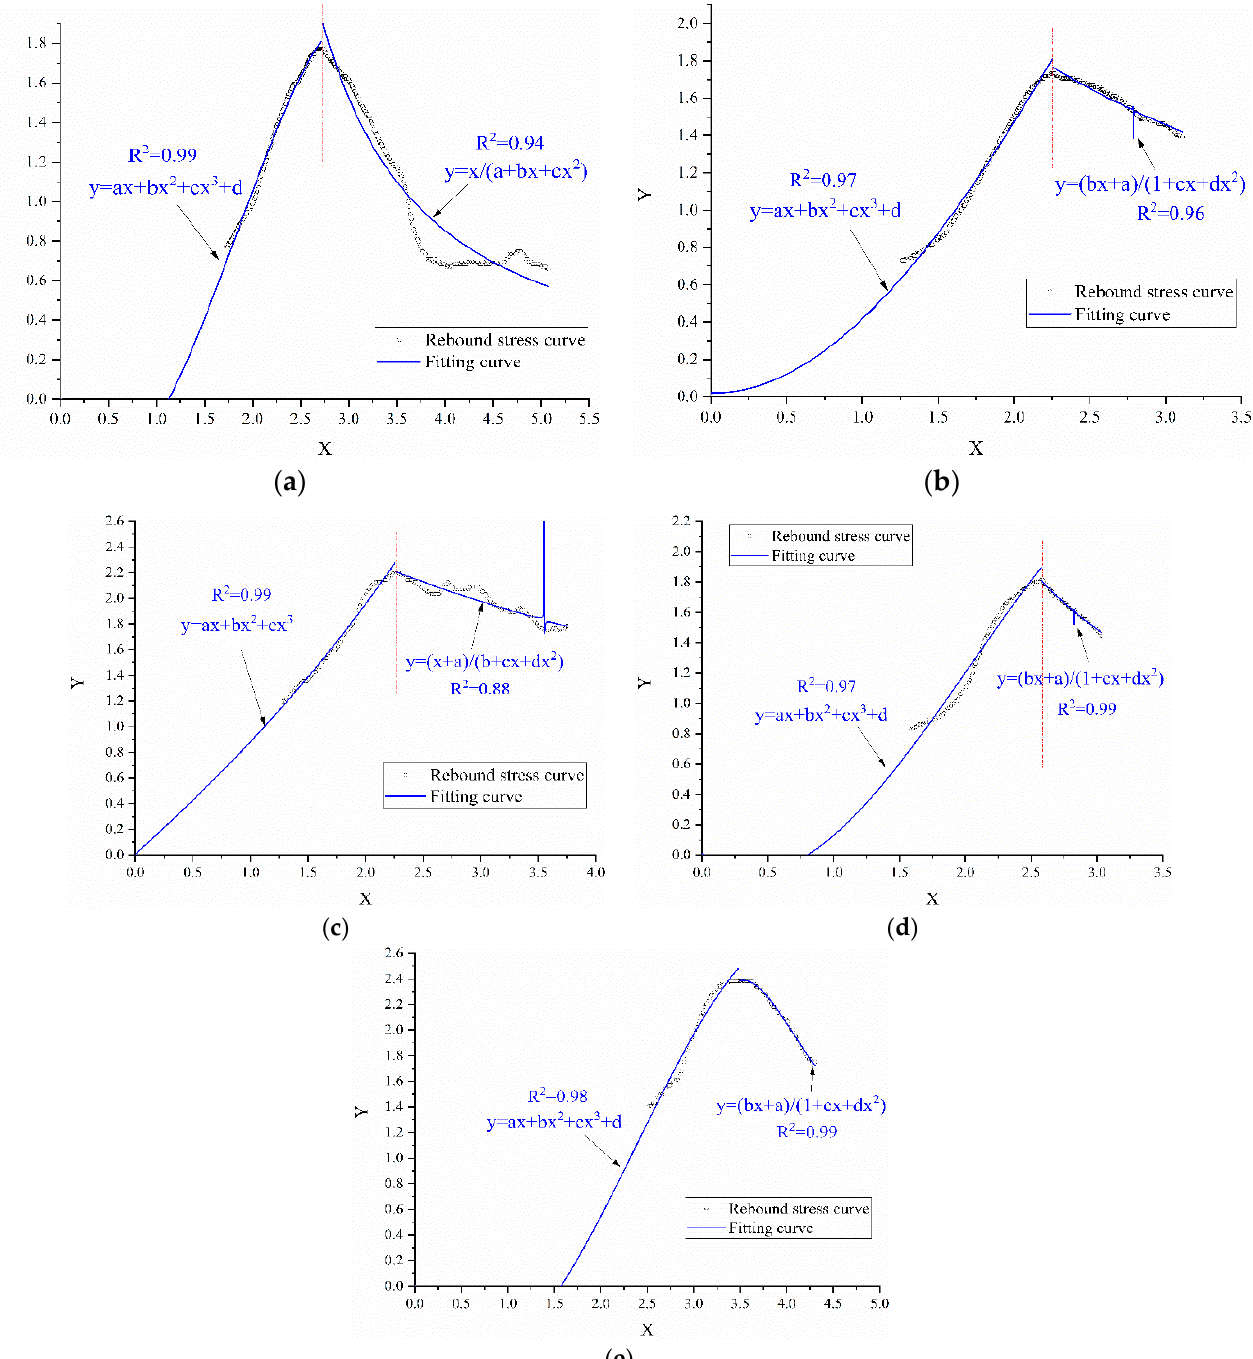
Figure 8. Fitting model of rebound stress curve of specimens in different experimental groups when the curing age is 3 d: ( a ) experimental group A, ( b ) experimental group B, ( c ) experimental group C, ( d ) experimental group D, and ( e ) experimental group E.